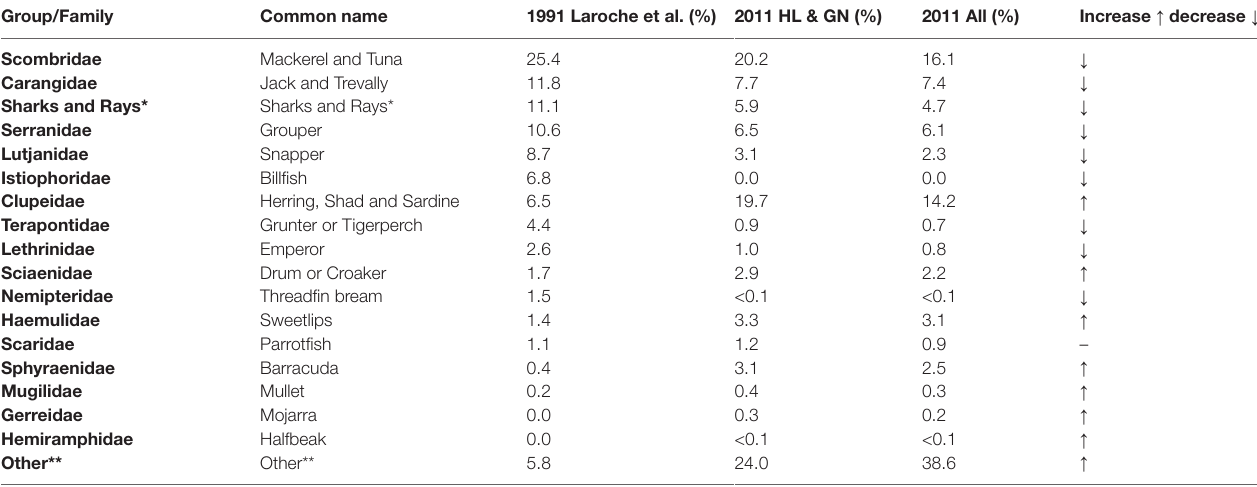
TABLE 2 | The major fish families caught in Morondava (Avaradrova and Betania) and their percentage contribution to the total catch (by weight) in 1991 and 2011with arrows indicating the direction of the trend between the two studies.